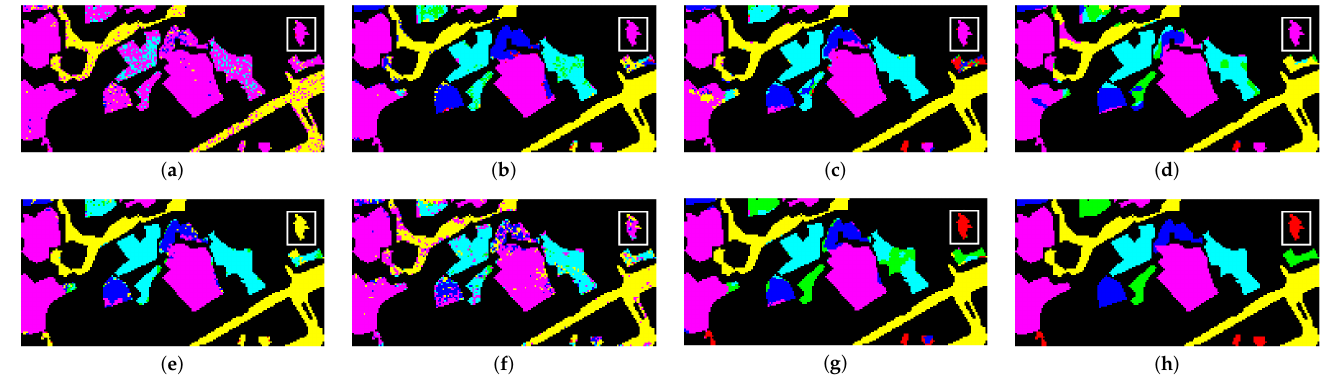
Figure 9. Class maps of GP. ( a ) SVM; ( b ) 2D-CNN; ( c ) 3D-CNN; ( d ) HybridSN; ( e ) PMI-CNN; ( f ) MSCNN; ( g ) Proposed method; ( h ) Reference